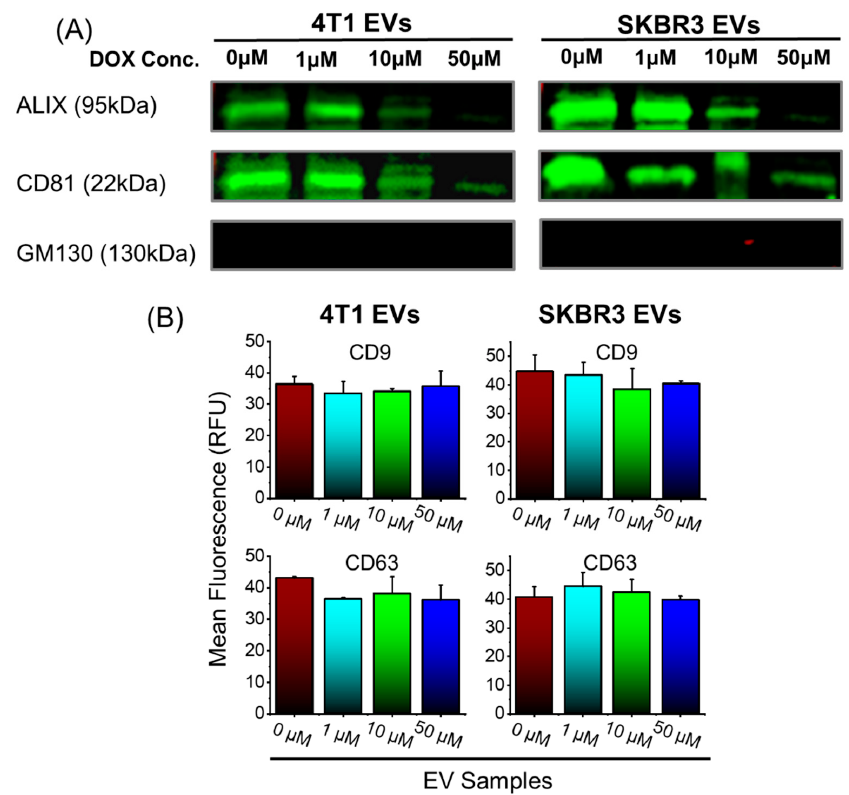
Figure 1. Isolation and molecular EV characterization of 4T1 and SKBR3 EVs loaded with Dox. ( A ) EV pellets (20 μ g protein/lane) were examined by Western blot to probe for EV-associated markers ALIX, CD81, and negative control (GM130). Representative images are shown for vesicle-associated proteins. ( B ) EV pellets were examined by TRIFIc exosome assay to probe for vesicle-associated markers CD9 and CD63. Data are presented as mean + SEM for three independent EV preparations.